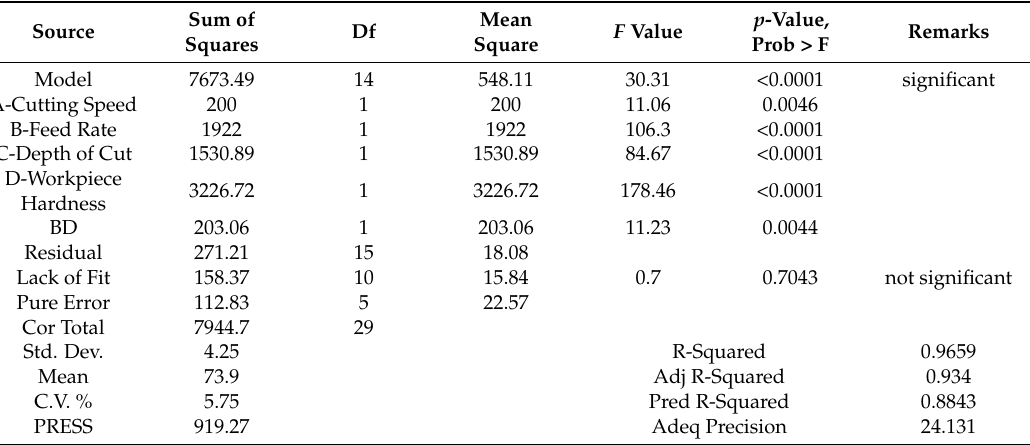
Table 9. Model of Tangential Force for CBN-II